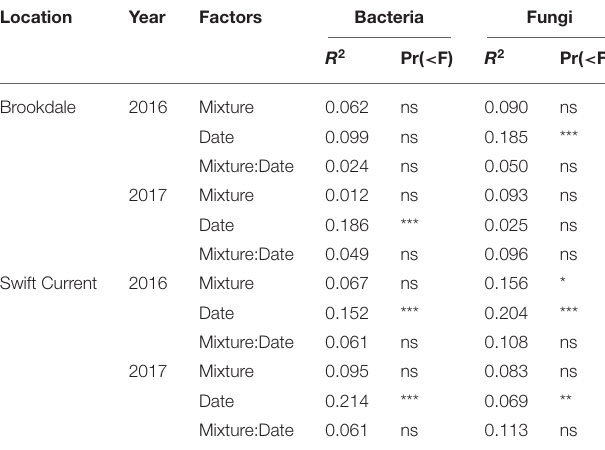
TABLE 5 | Permanova results of the effect of crop species mixture (monoculture, three, six, and nine spp.) and sampling date (mid or late growing season) on the bacterial and fungal community composition at the Brookdale and Swift Current research sites in 2016 and